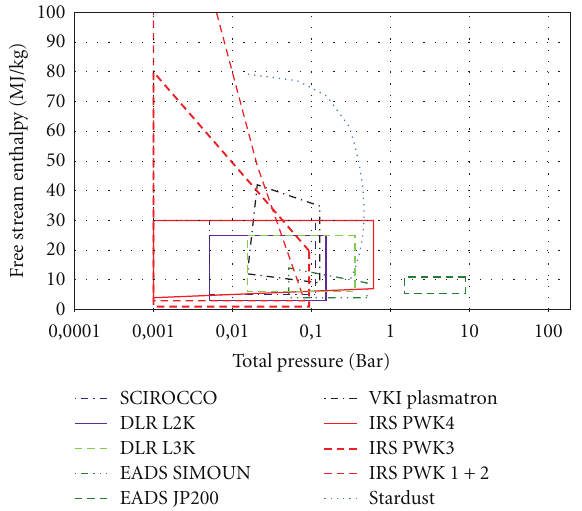
Figure 7: Stagnation point envelopes of some European facilities for TPS testing and reentry trajectory of Stardust (for a European standard model of 50 mm at the exception of JP